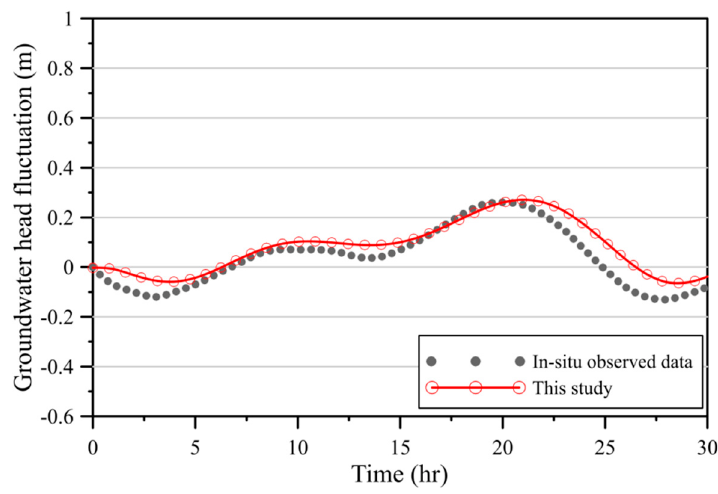
Figure 18. Comparison of the computed groundwater response with measured data.